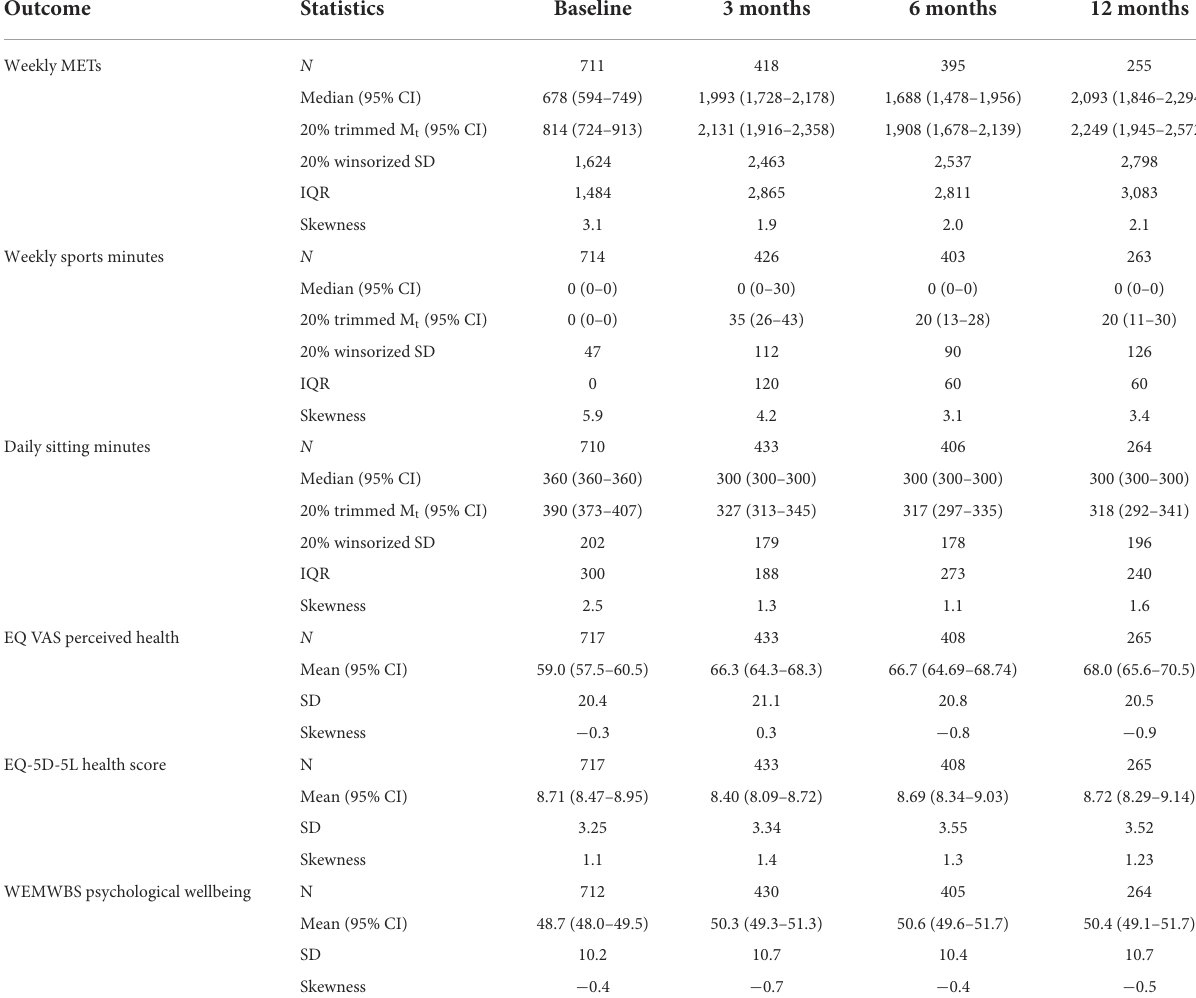
TABLE 2 Descriptive statistics and 95% CIs of outcome measures at baseline, 3, 6, and 12 months.